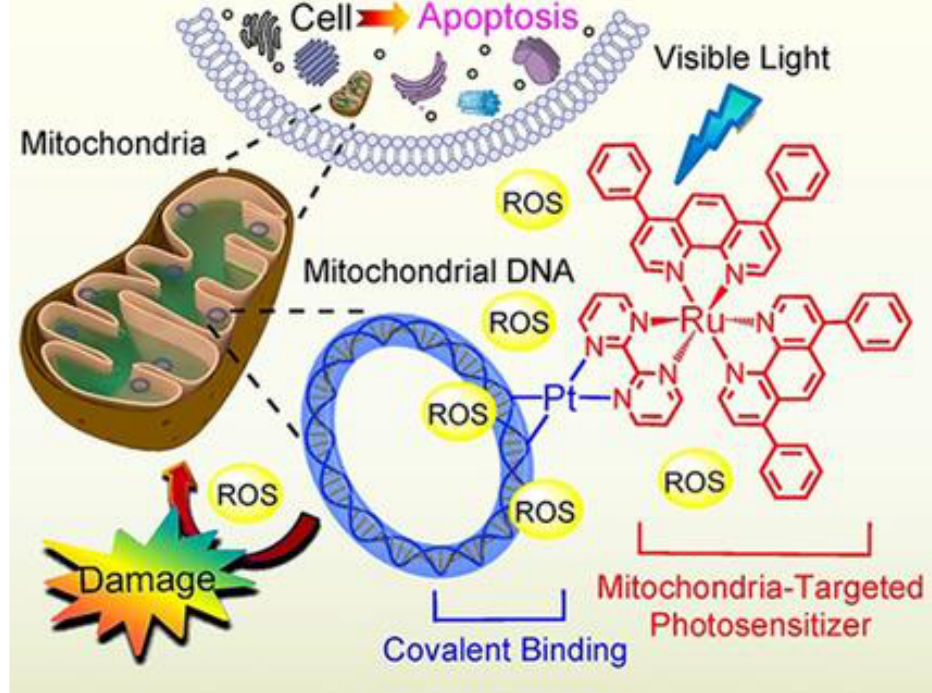
Figure 3. Representation of the mechanism of action of complex 5. (Reprinted with permission from ref. [31]. Copyright 2018 John Wiley and Sons).